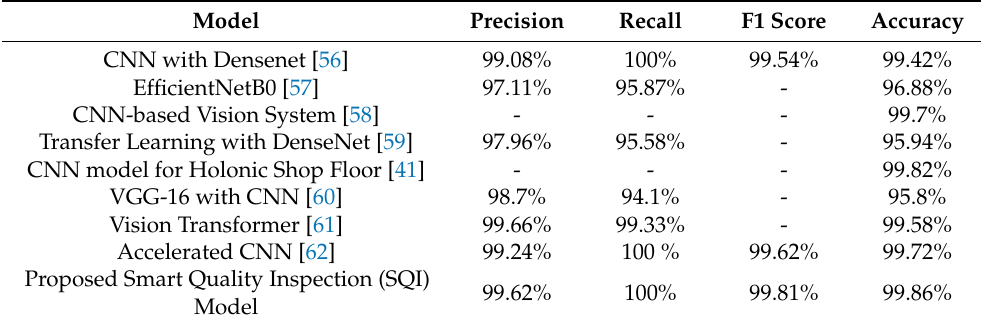
Table 4. Comparison of the performance of our proposed model with other models from pub- lished works.